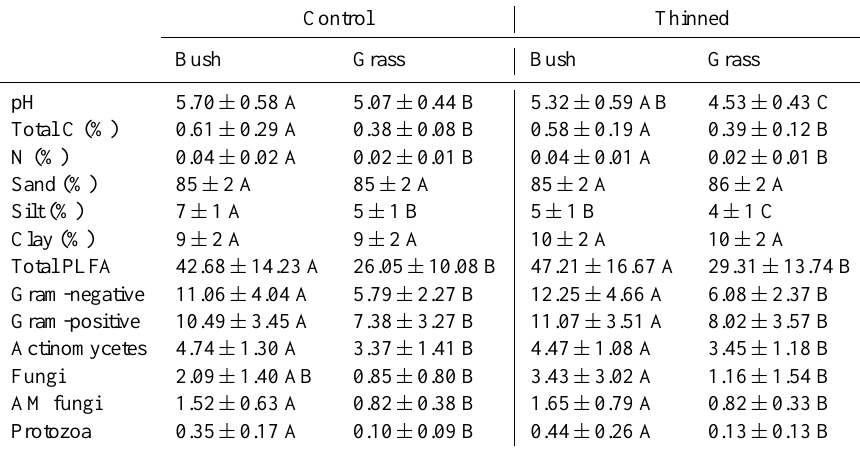
Table 1. Soil pH, C, N, texture, and PLFA concentrations. PLFAs are reported as nmolg − 1 dry weight. All values are least-squares means ± standard deviation, and values within a row with different letters are significantly different ( p = 0 . 05). N = 27 except for soil texture values, where N = 9. The main effect of treatment (control vs. thinned) was not significant except for silt ( p = 0 . 0007). The main effect of vegetation (bush vs. grass) was significant ( p = 0 . 001) in all cases except for sand and clay, which were not significant. The interaction of treatment × vegetation was not significant in all